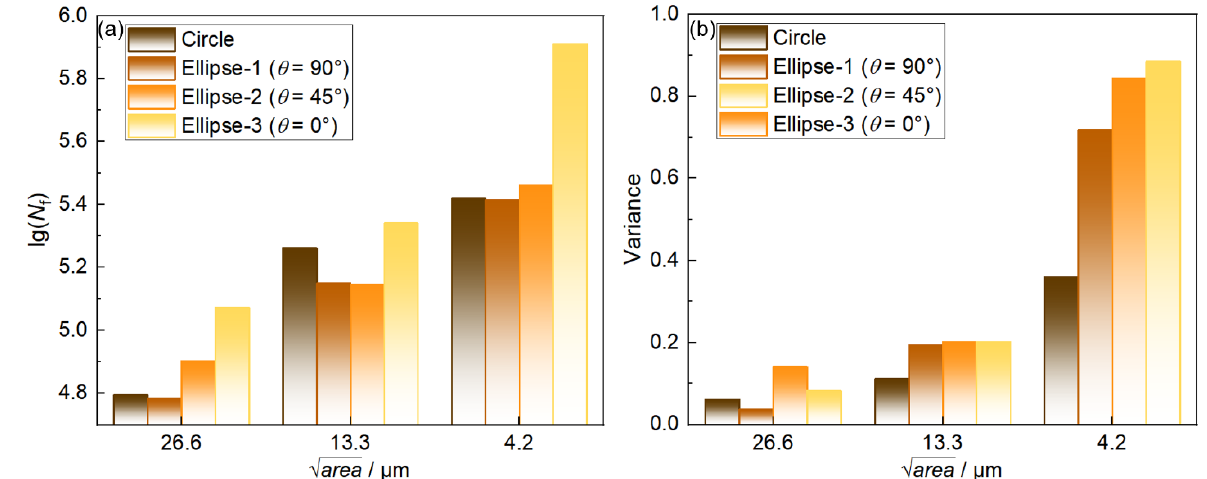
Figure 8. ( a ) The average fatigue life of different inclusions without the assistance of shape parameter ξ ; ( b ) the variation of variance values of fatigue life with different inclusions caused by different